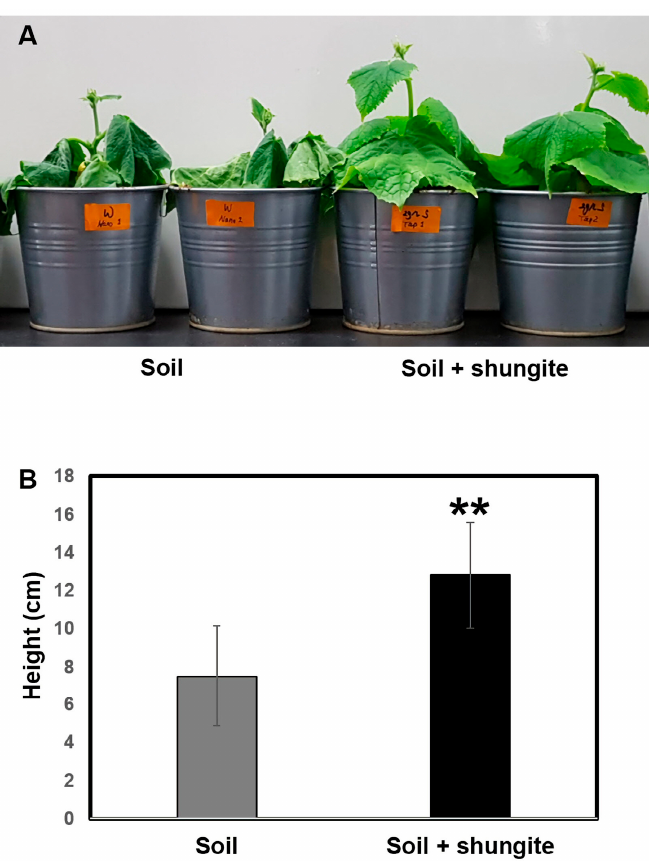
Figure 2. E ff ects of shungite as a physiological indicator of drought tolerance in cucumber. ( A ) Shungite-added group shows tolerance under drought conditions. Representative image after 21 days. ( B ) Comparison of plant heights. Error bars represent mean ± standard deviation (SD), ( n = 8). Asterisks indicate statistical significance (Student’s t -test, ** p ≤